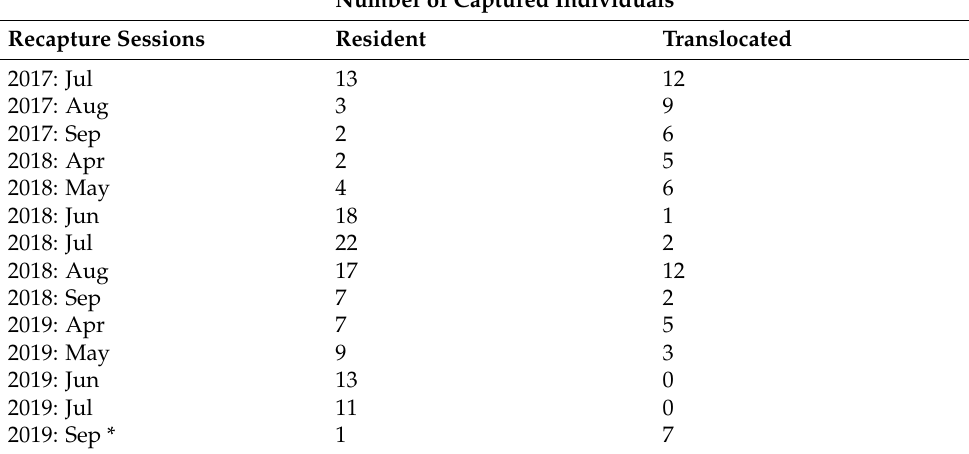
Table 1. Number of resident and translocated individuals captured at each session in the colony of Momina tsarkva. The sessions in June and July mainly included resident juveniles that emerged from the burrows for the first time at the end of May. * This session was performed with the primary aim of removing radio collars from the translocated animals, which is why the translocated individuals predominated.